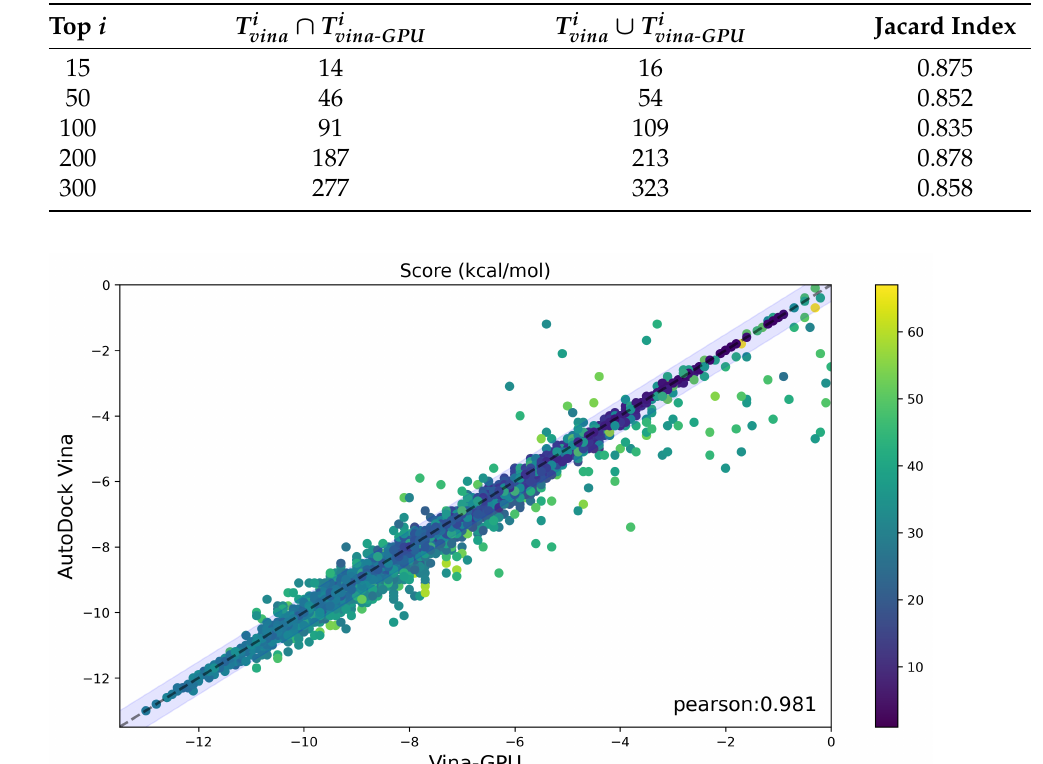
Table 1. The Jacard indexes J i on the top i subsets of Vina-GPU and AutoDock Vina.